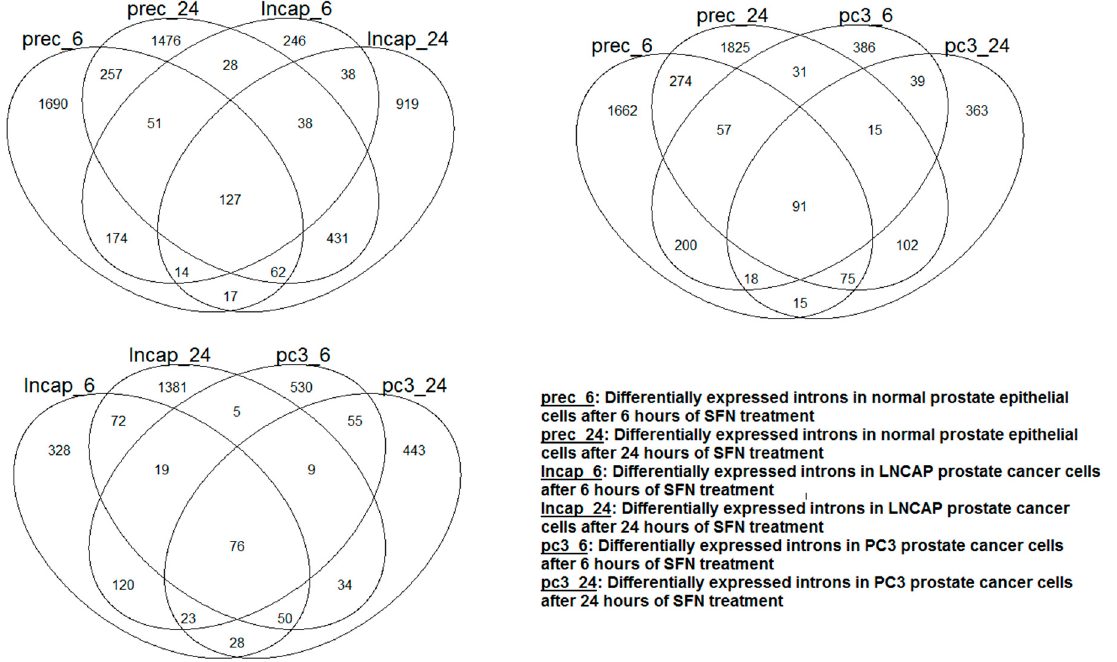
Figure 3. Venn diagram showing the overlap of the introns that were differentially expressed after SFN treatment in each cell type. The overlap was small between the cell types regardless of the cell type and treatment period.